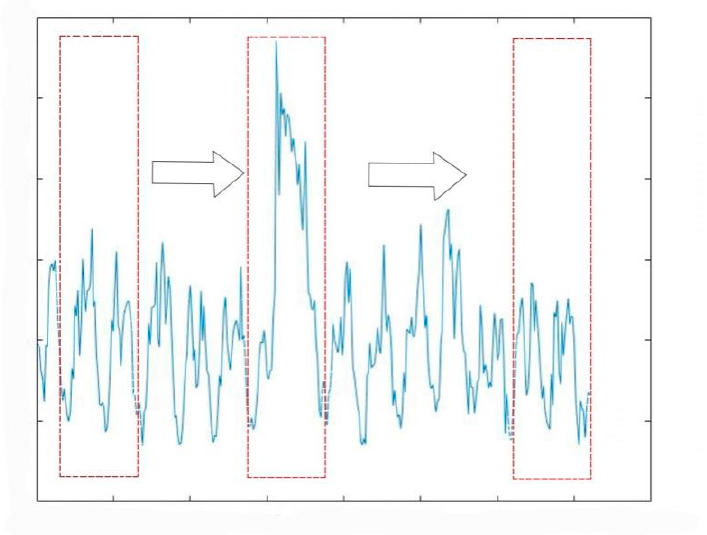
Figure 8. About the abnormal data handling of compressed windows.